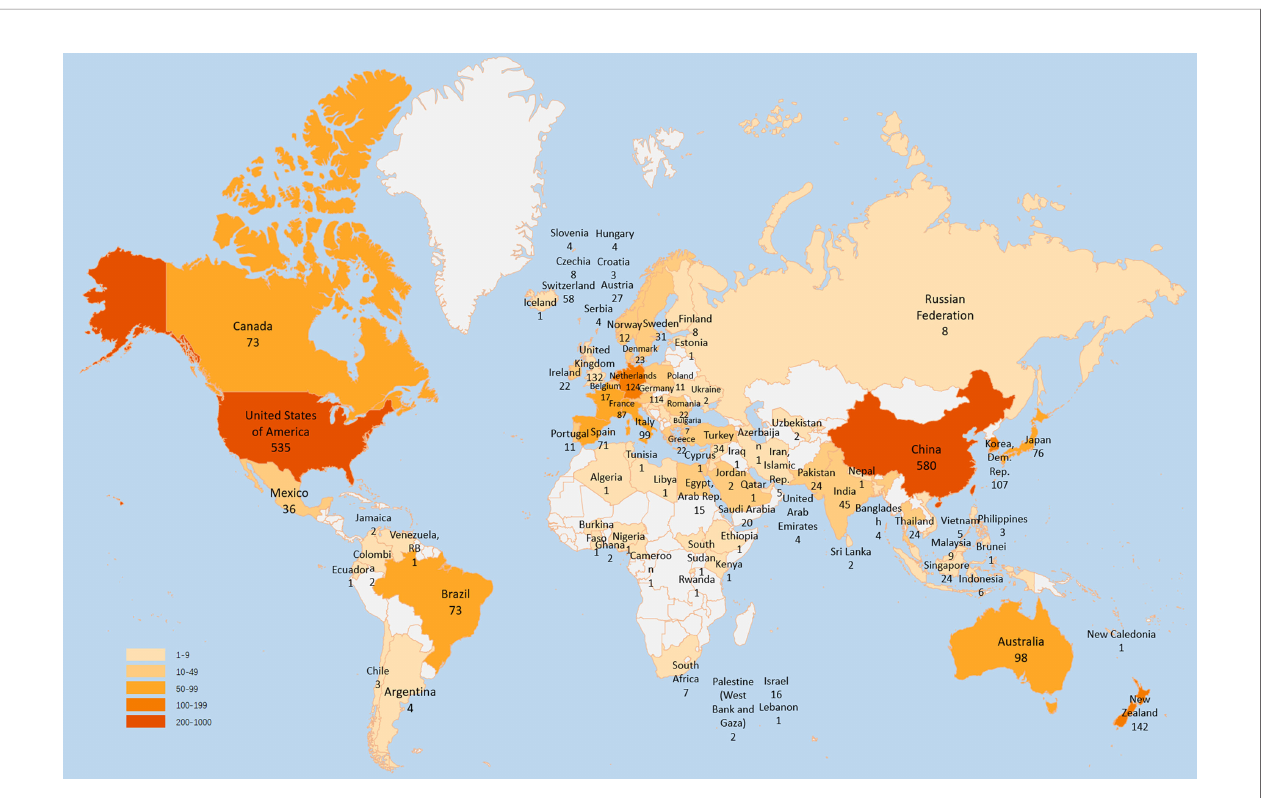
FIGURE 1 | Geographical distribution of publications on GA research, 2012 –